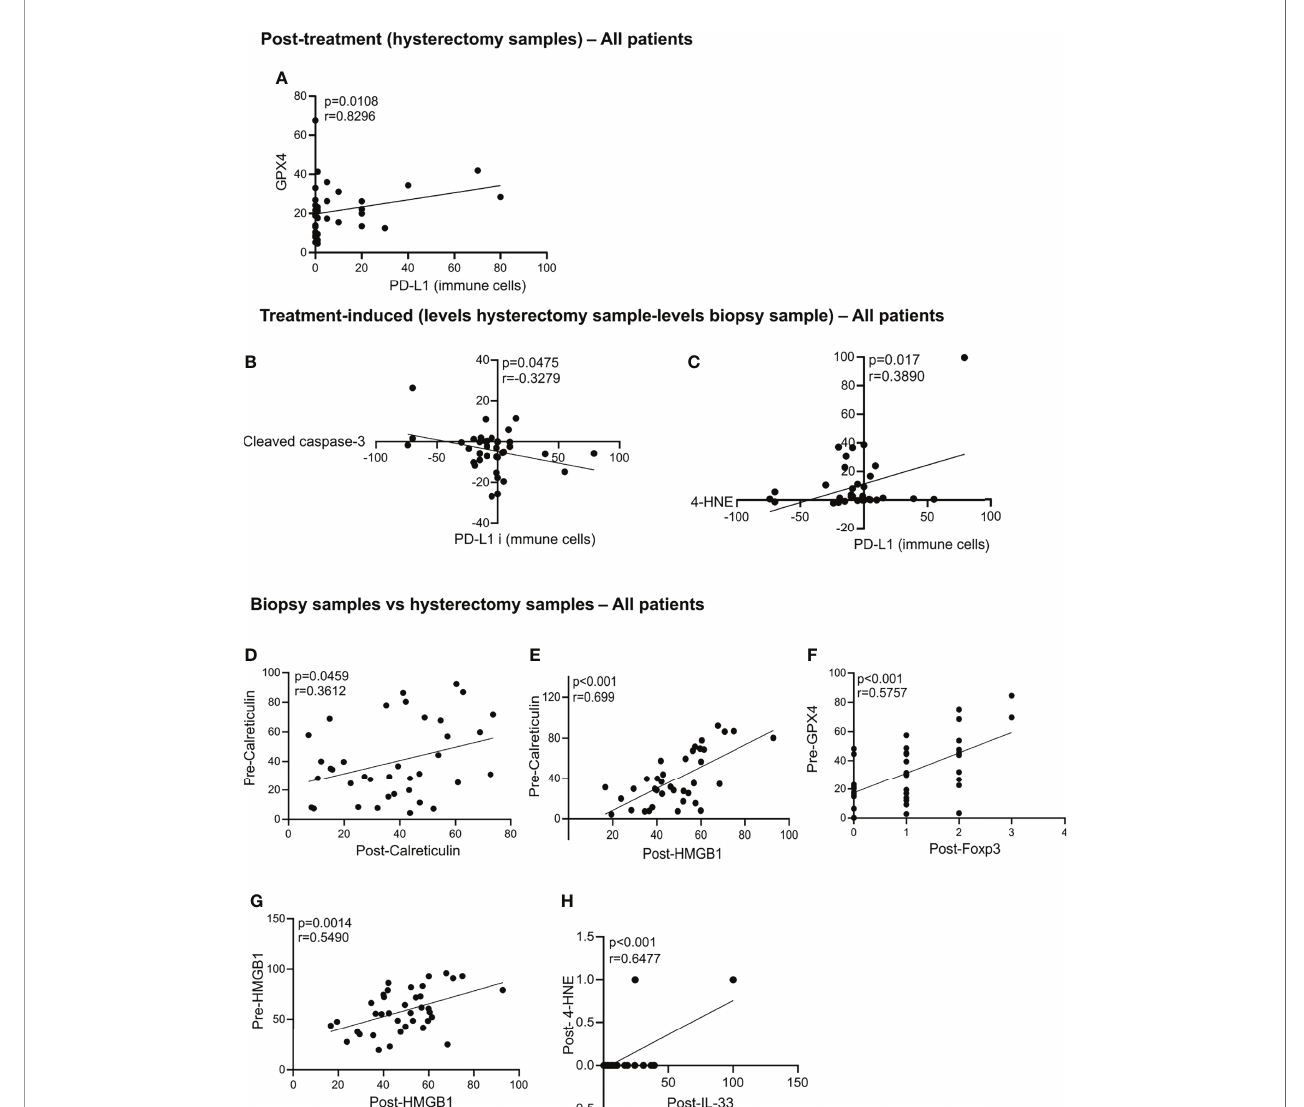
FIGURE 4 | Statistically signi fi cant correlation in the hysterectomy samples, treatment-induced and biopsy samples vs hysterectomy samples. Statistically signi fi cant correlations were found post-treatment between GPX4 and PD-L1 (A) . Correlation in the treatment-induced analysis between PD-L1 and cleaved caspase-3 (B) and 4-HNE and PD-L1 (C) . Correlations between the biopsy samples vs hysterectomy samples in all patients are signi fi cant for pre-calreticulin and post-calreticulin (D) ; pre-calreticulin and post-HMGB1 (E) ; pre-GPX4 and post-FoxP3 (F) ; pre-HMGB1 and post-HMGB1 (G) and post-4-HNE and post-IL-33 (H) . All p-values and correlation coef fi cients were evaluated with two-sided test of correlation (Genstat 64-bit Release 20.1) are indicated on the graphics which were generated with GraphPad (version